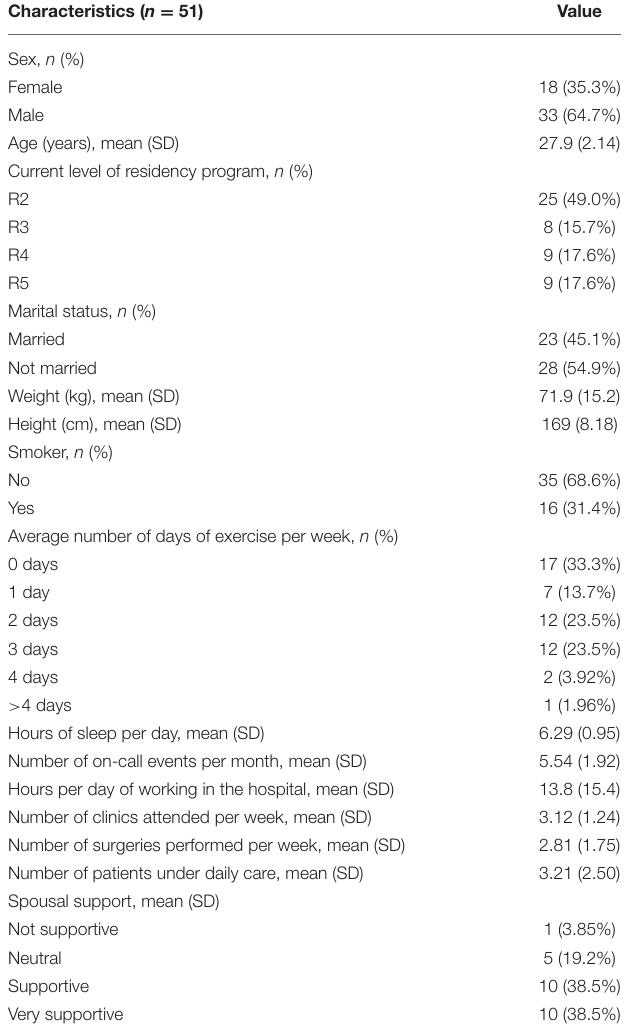
TABLE 1 | Descriptive statistics of the study